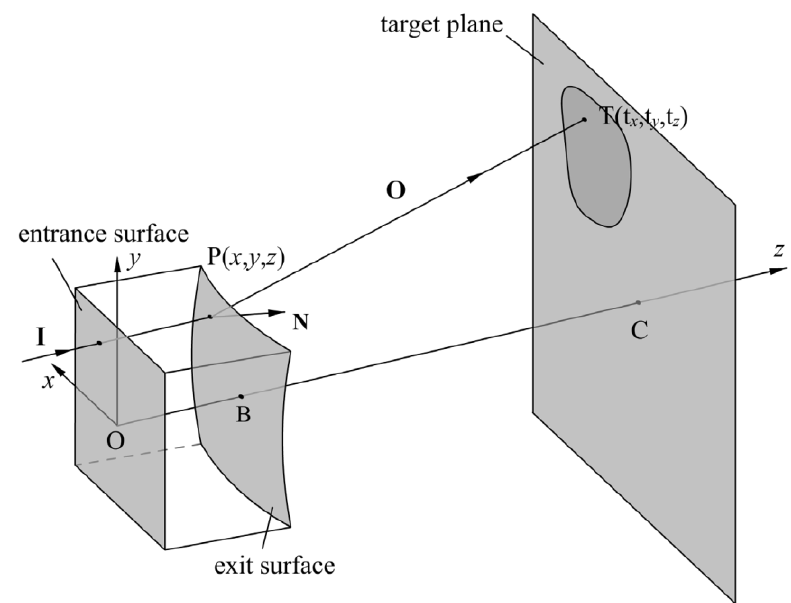
Figure 5. Geometric scheme of the freeform surface design [104].